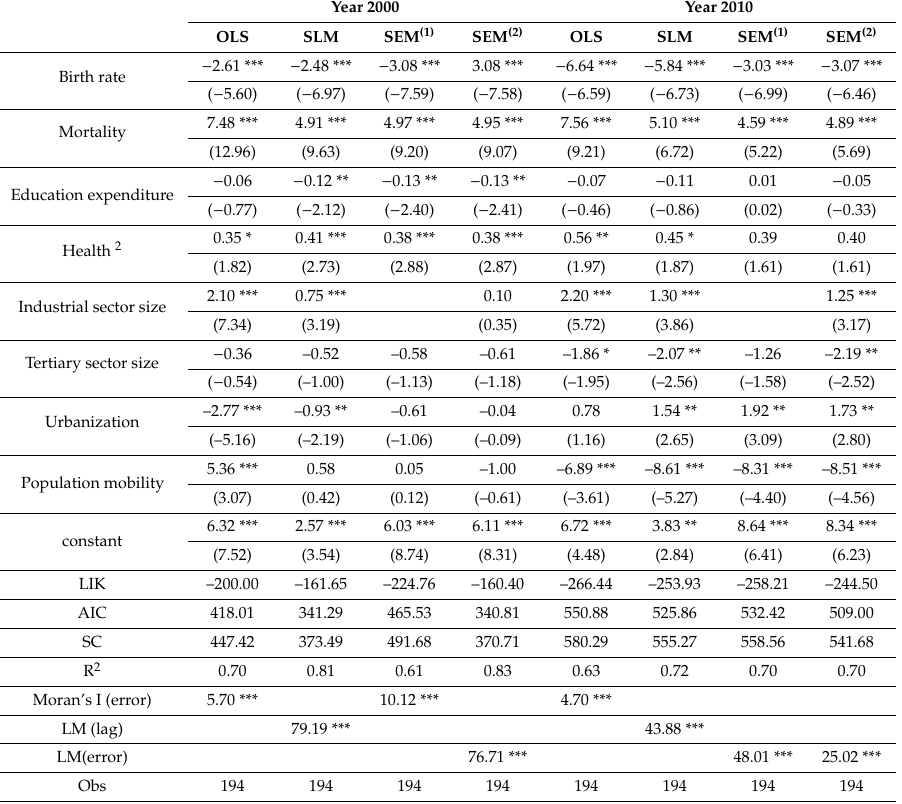
Table 4. Spatial econometric estimation